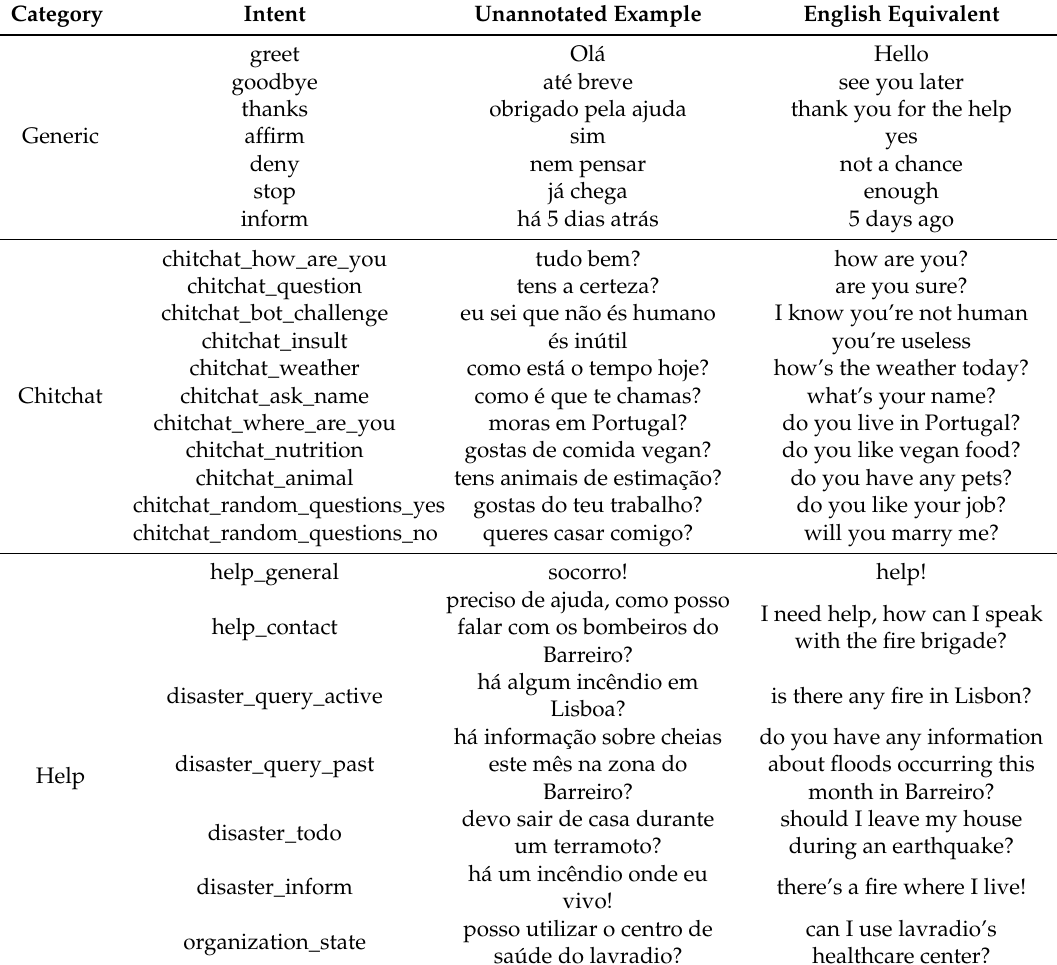
Table 6. Chatbot implemented intents with unannotated